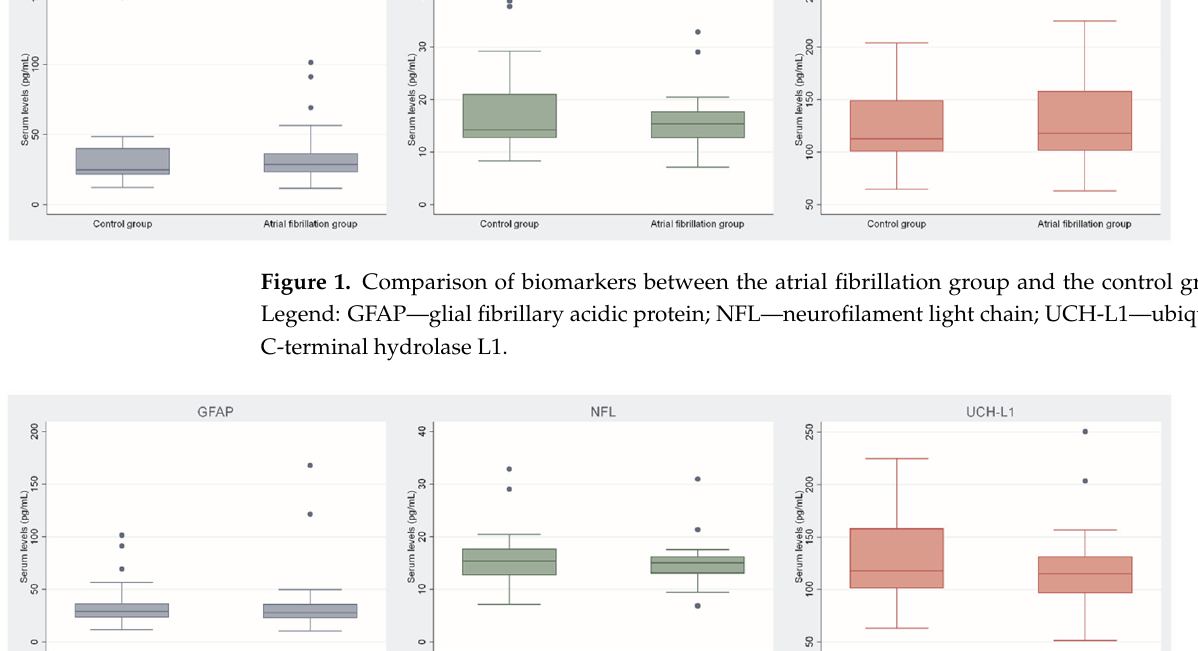
Figure 1. Comparison of biomarkers between the atrial fibrillation group and the control group. Legend: GFAP—glial fibrillary acidic protein; NFL—neurofilament light chain; UCH-L1—ubiquitin C-terminal hydrolase L1.